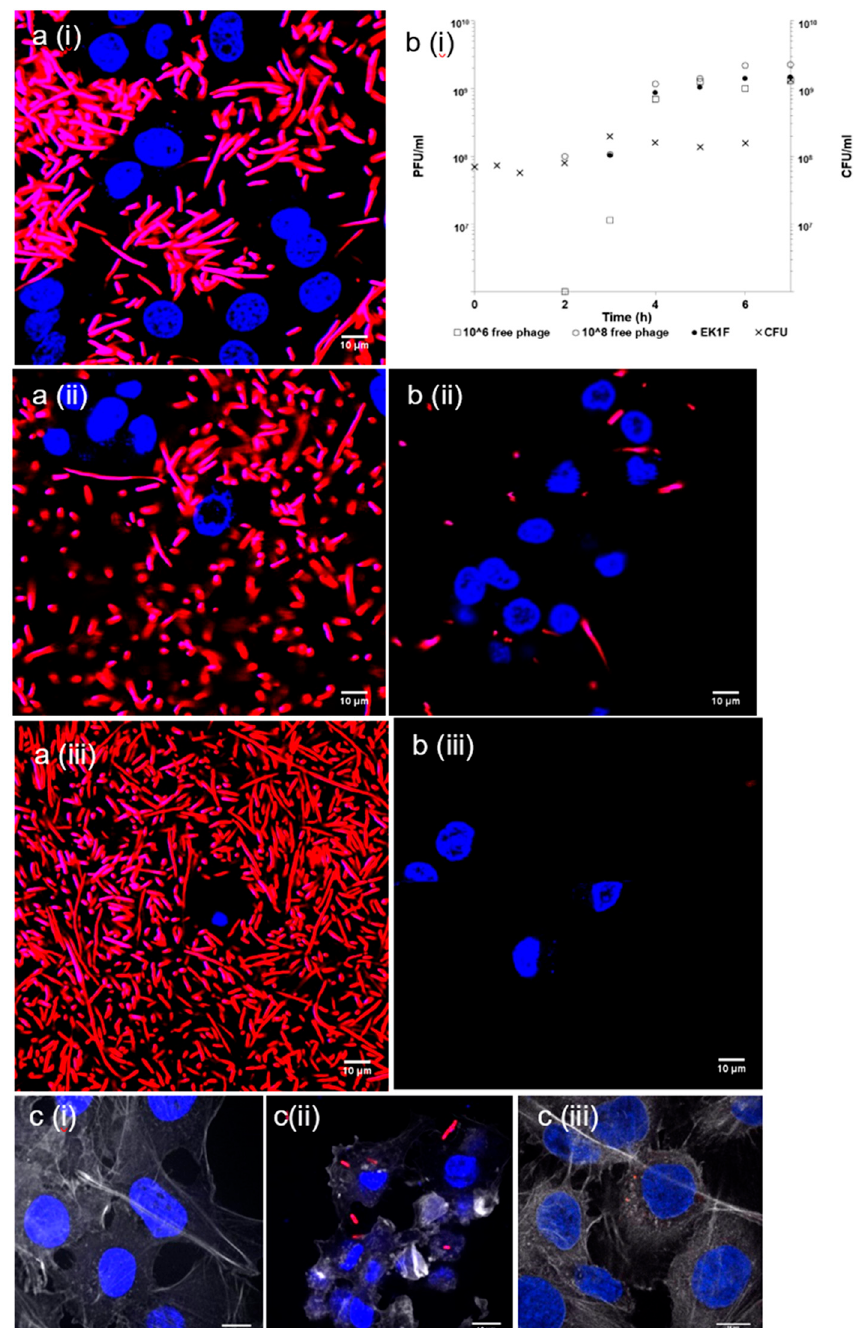
Figure 8. Live and confocal microscopy images of E.coli strain EV36-RFP cells (red) treated with microencapsulated EK1F in the presence of epithelial cells (blue): ( a ) Controls without phages (i) 2 h, (ii) 3 h, and (iii) 5 h following incubation of epithelial cells with E. coli strain EV36; ( b ) (i) phage amplification of free phages and EK1F in the presence of E.coli strain EV36, and live microscopy images of EK1F treated samples at (ii) 3 h and (iii) 5 h following incubation of epithelial cells with E.coli strain EV36; ( c ) (i) control epithelial cells not exposed to E.coli strain EV36, (ii) damaged actin visible for epithelial cells exposed to EV36 with no phage treatment, and (iii) the condition of actin of epithelial cells exposed to E.coli strain EV36 and treated with EK1F.